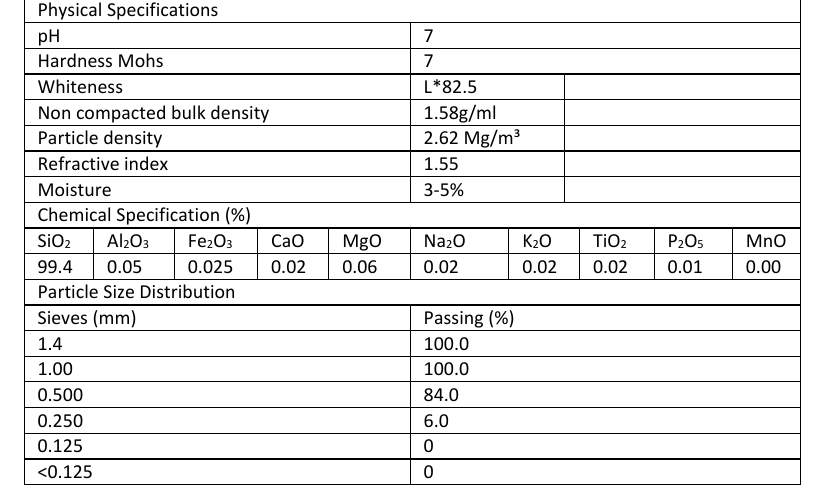
Table 1. Characteristics of